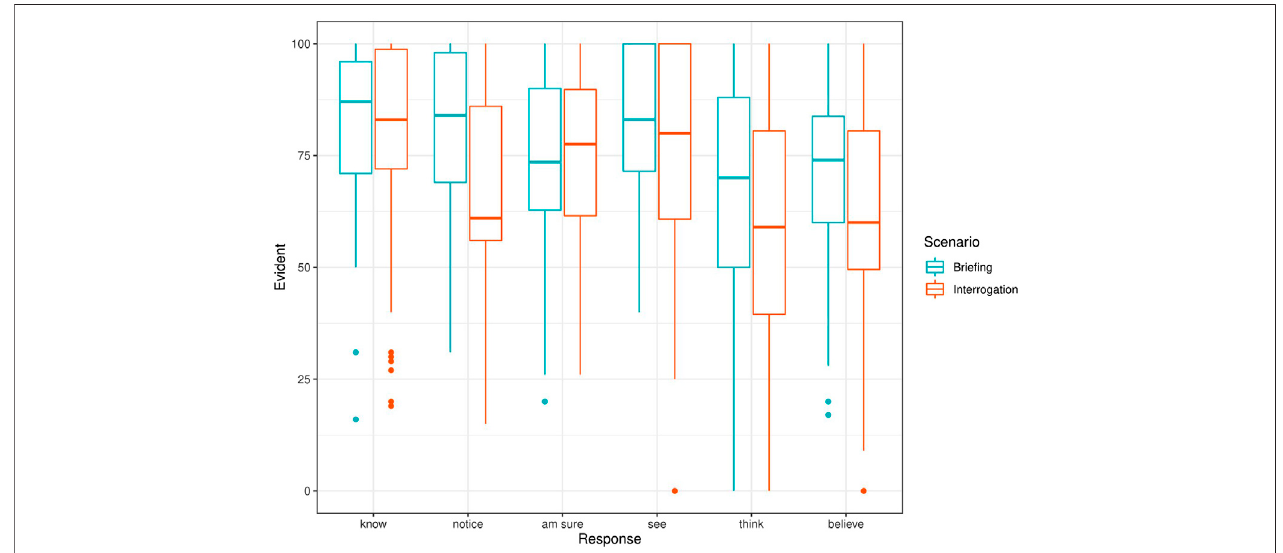
FIGURE 1 | By-expression evidentiality ratings for each scenario (brie fi ng in blue, interrogation in red). The plot shows the median of the evidentiality ratings (line) and the upper quartile and lower quartile (box). Whiskers extend to the scores outside the quartiles. Dots represent outliers.